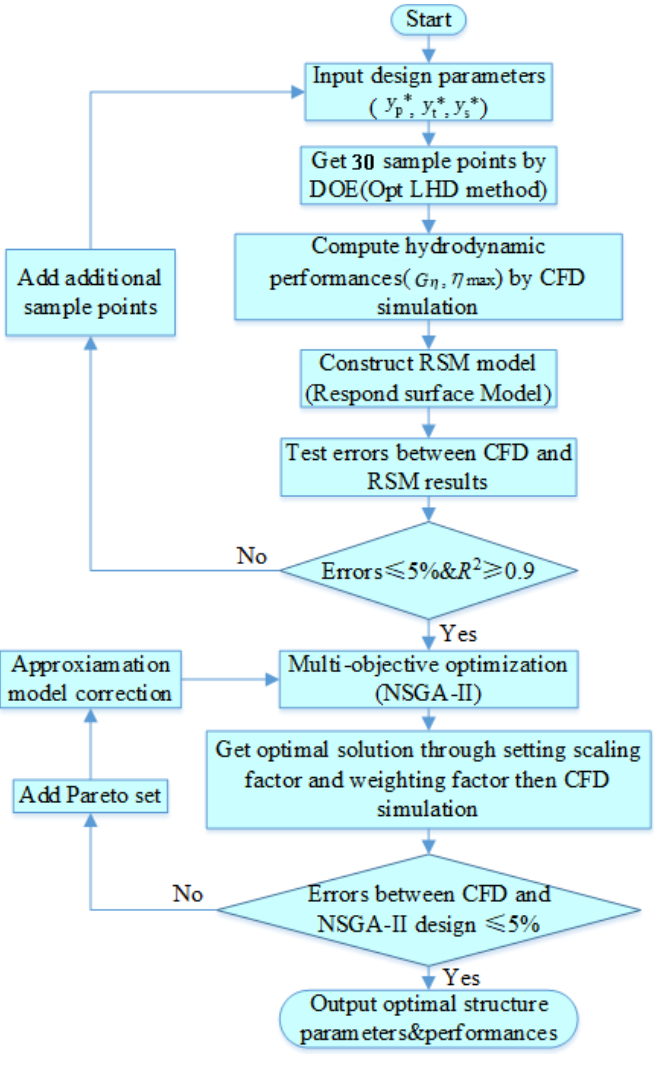
Figure 13. Multi-objective optimization process.